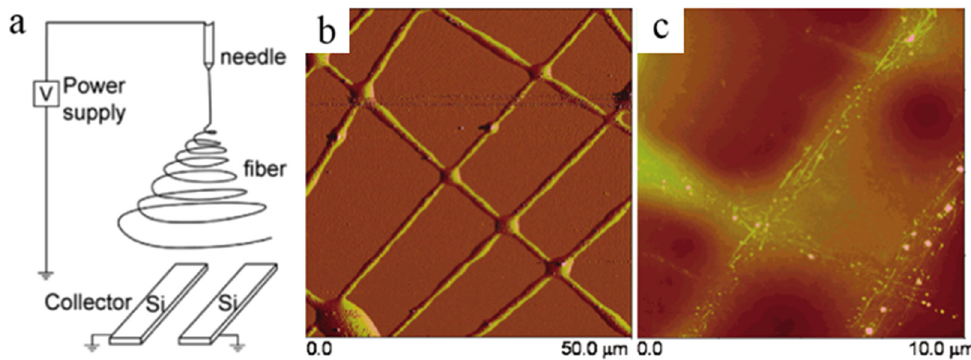
Figure 16. ( a ) Schematic of the collector with two pieces of conductive silicon strips separated by a gap. Reproduced with permission [107]. Copyright 2003, American Chemical Society. AFM images of ( b ) cross-aligned SWNTs/PVP composite fibers and ( c ) cross-aligned SWNT array after etching PVP. Reproduced with permission [108]. Copyright 2004, American Chemical Society.